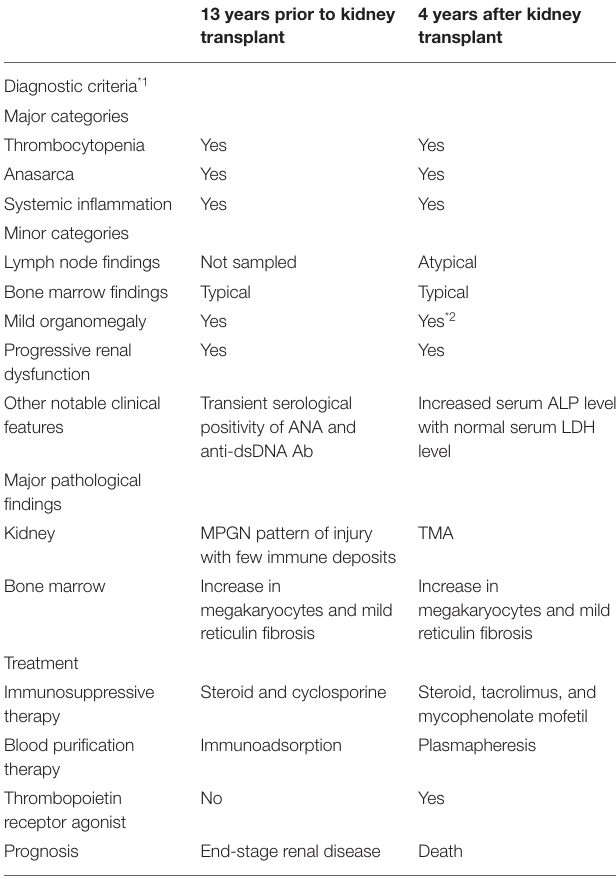
TABLE 2 | Summary of clinical and pathological features of the